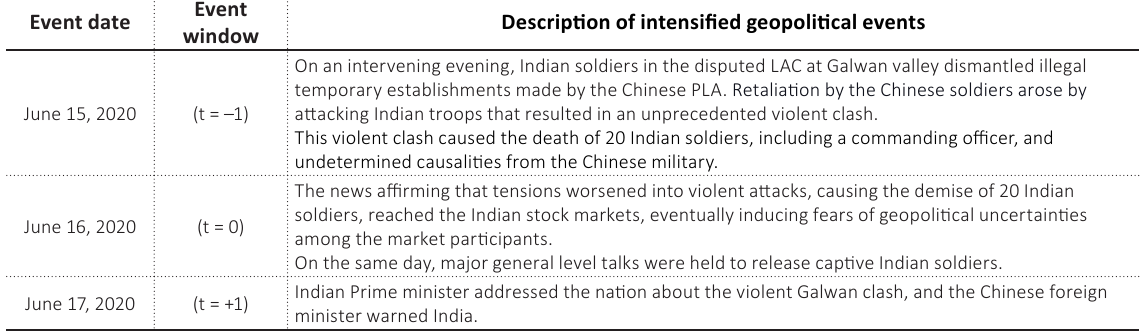
Table 1. Intensified geopolitical event window for India-China tensions,